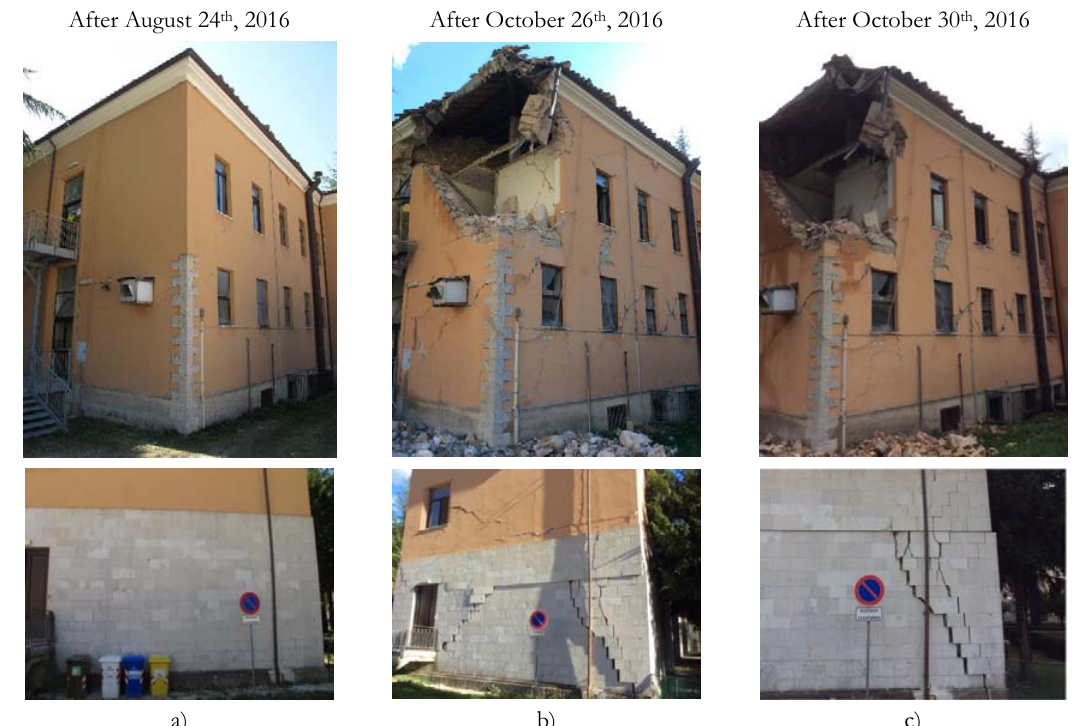
Figure 5: Damage observed in “Pietro Capuzi” school after the earthquakes that occurred on: a) August 24 th , 2016, b) October 26 th , 2016, and c) October 30 th , 2016 [11, 12].